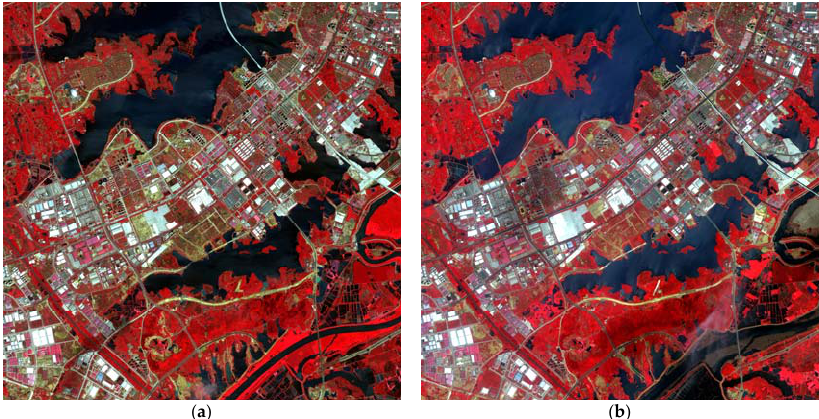
Figure 2. The pseudocolor VHR images acquired by GF ‐ 2 satellite on ( a ) 11 April 2016; and ( b ) 1 September 2016.